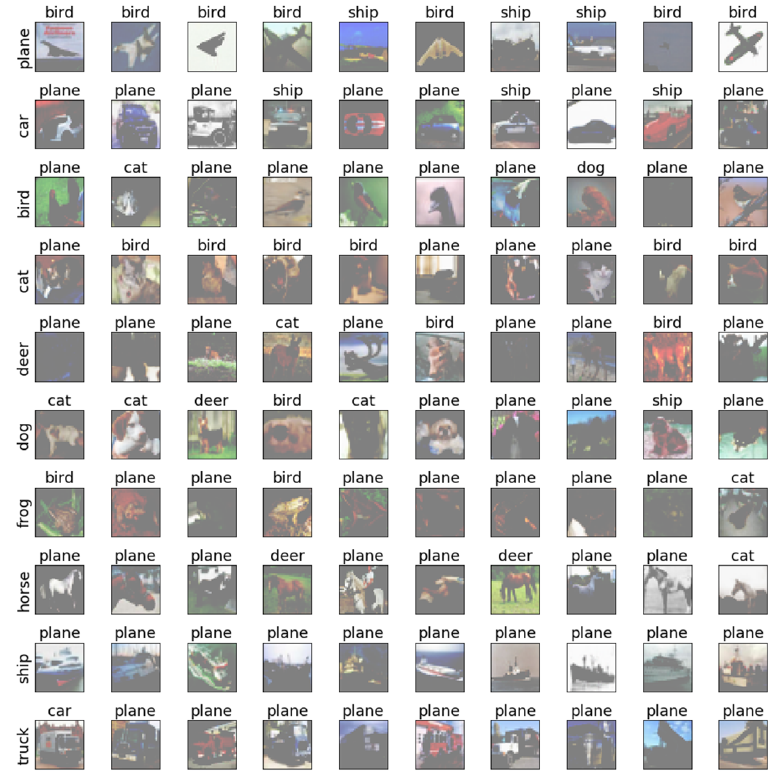
Figure 15. The adversarial examples of CW for Cifar10 and ResNet18.